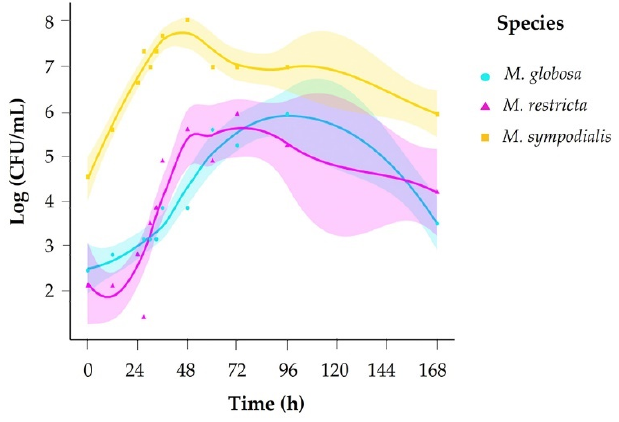
Figure 1. Growth curve for Malassezia species in mDixon broth. Table 1. Times of the exponential and stationary phases of Malassezia according to the growth curve. M.